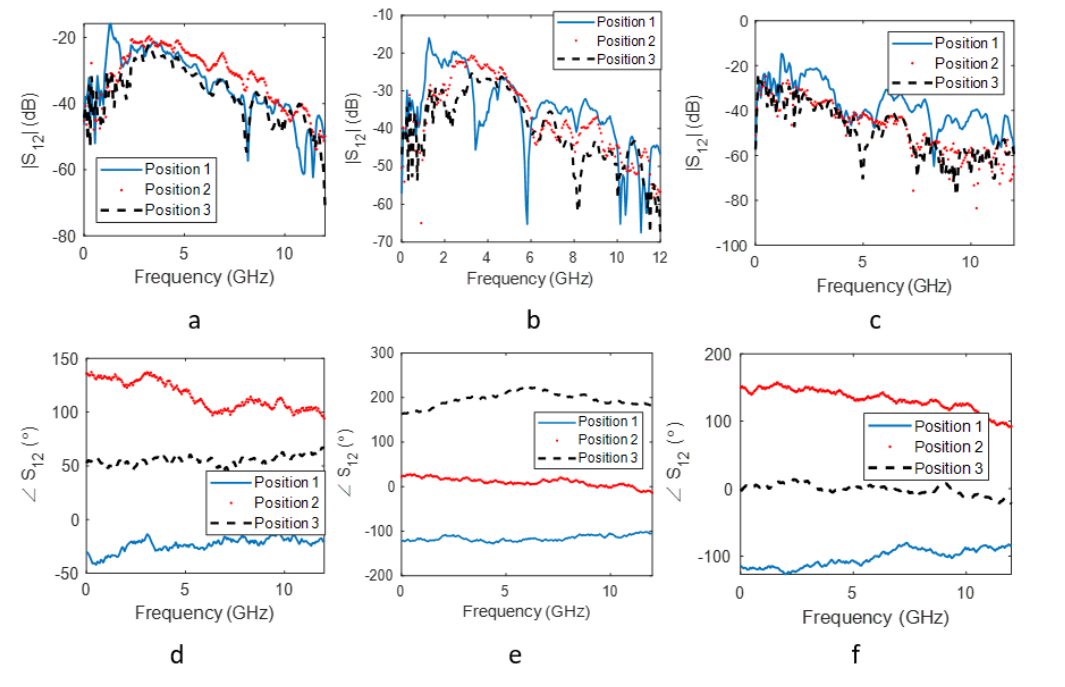
Figure 5. The insertion loss magnitude for ( a ) the small carrot, ( b ) the large carrot and ( c ) multiple carrots. The insertion loss phase for ( d ) the small carrot, ( e ) the large carrot and ( f ) multiple carrots.